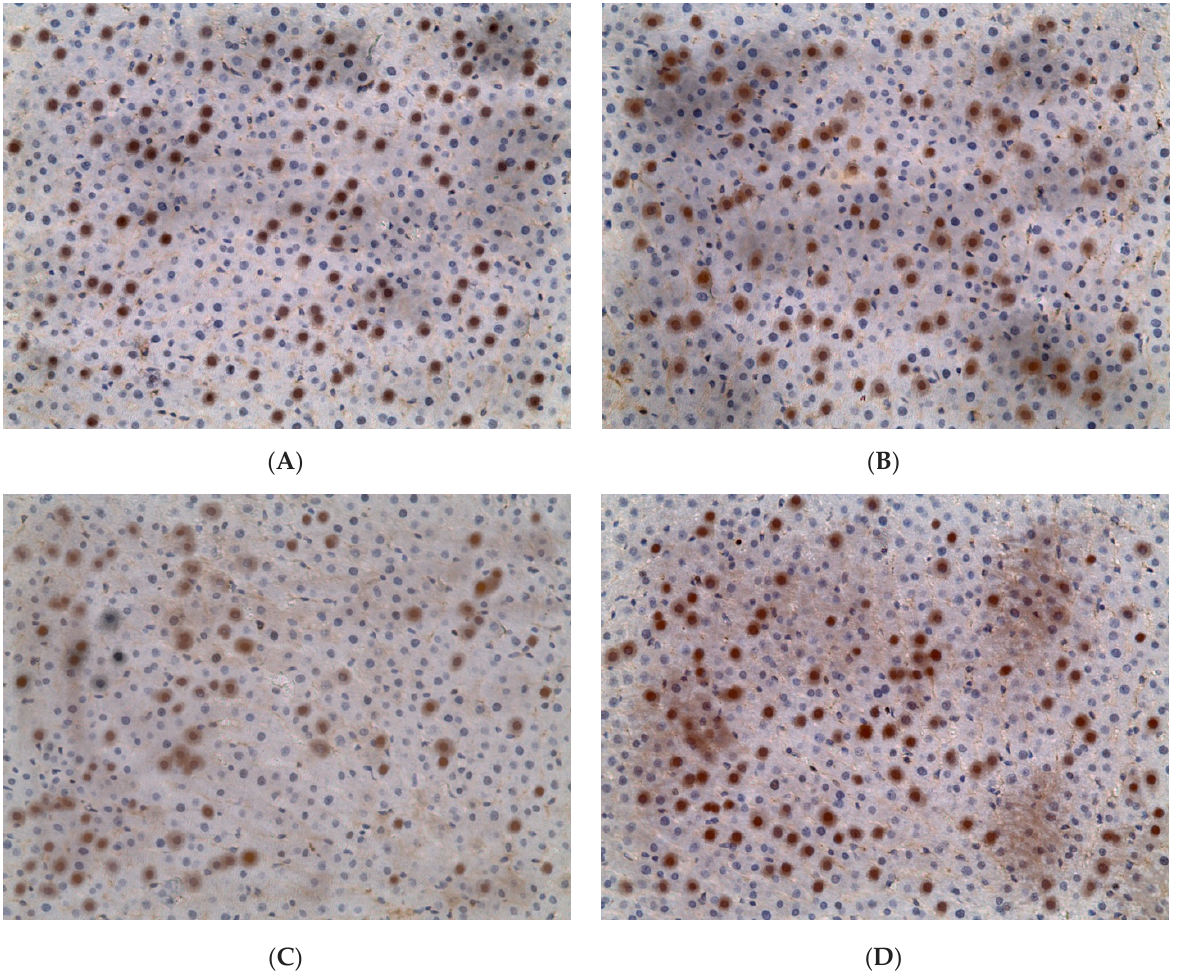
Figure 9. Levels of PER2 expression in hepatocytes of rats. *** ( p ≤ 0.0005)—in comparison with the parameters of animals of the control group.